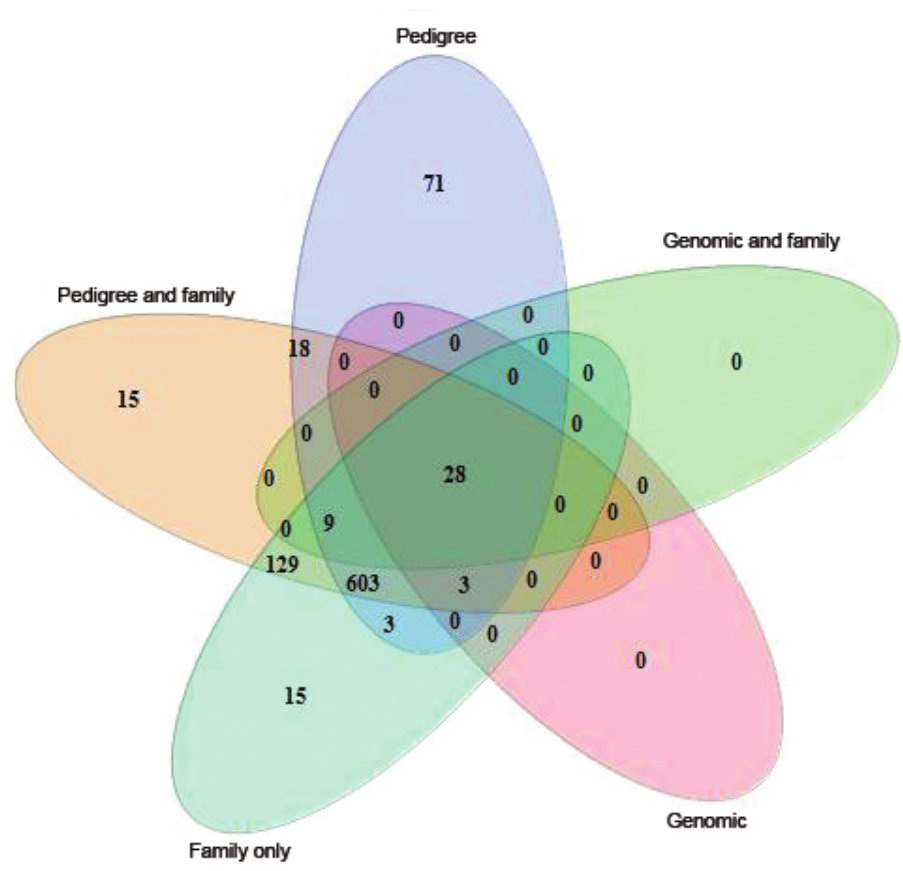
Figure 4 - Overlapping detected SNP-trait associations from fixed effect model with family included, pedigree-based relatedness, or genomic related- ness, each of those mixed model analyses distinctly with and without the fixed effect of family